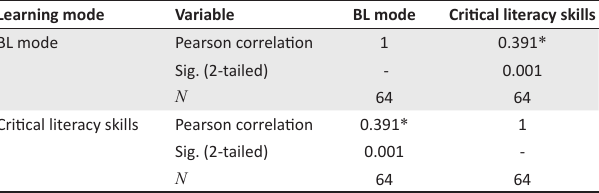
TABLE 3: Correlation table showing the relationship between students’ exposure to the blended learning mode and the development of online critical literacy